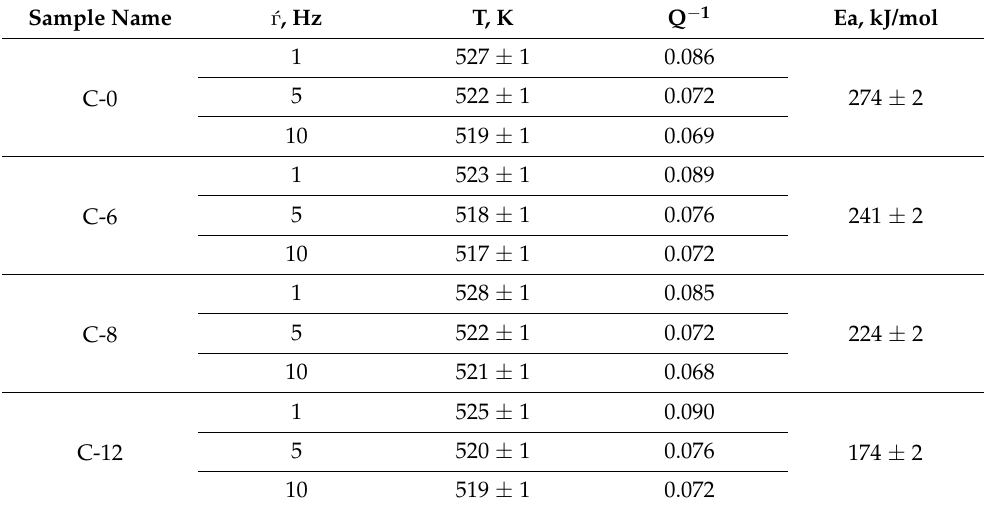
Table 2. Calculated activation energy values of the carbonization process for differently filled